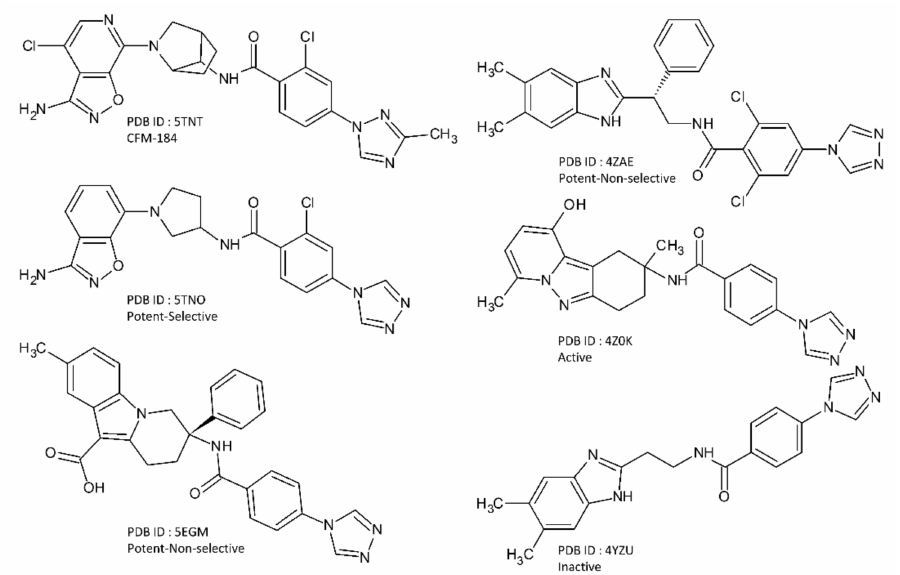
Figure 8. The 2D chemical structure of the co-crystallized FIXa ligands.